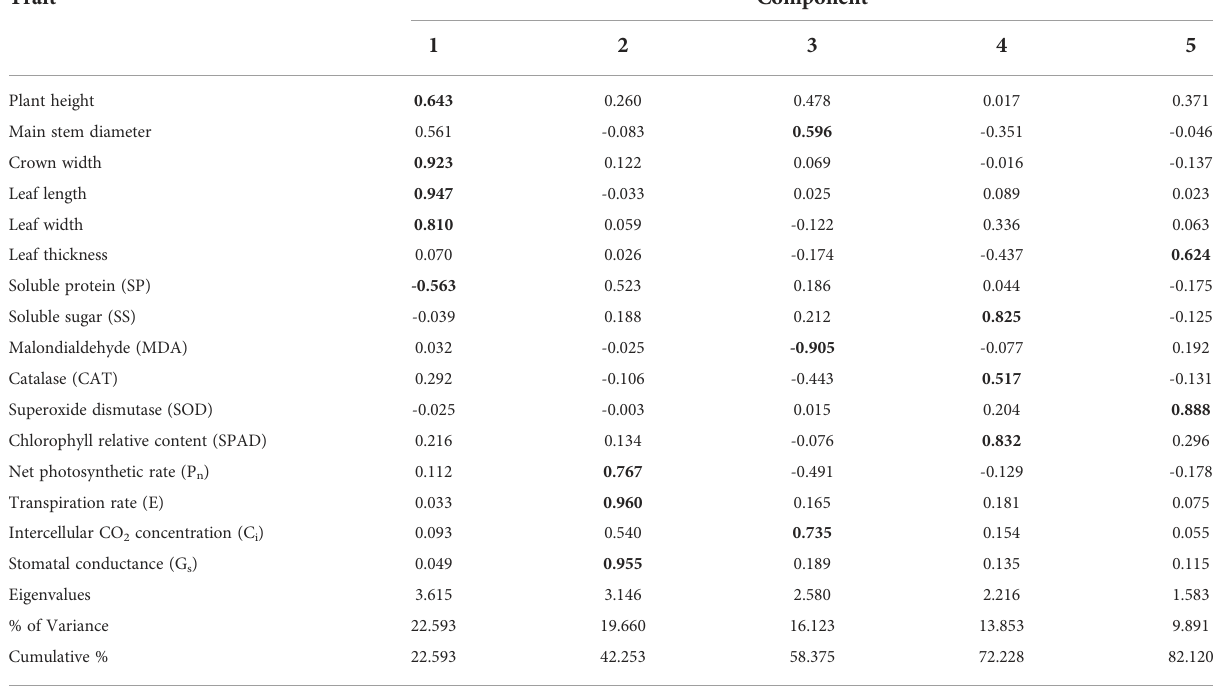
TABLE 3 PCA based on the HSTCs of the growth and leaf physiological indices of 15 blueberry seedling cultivars under high soil pH stress.